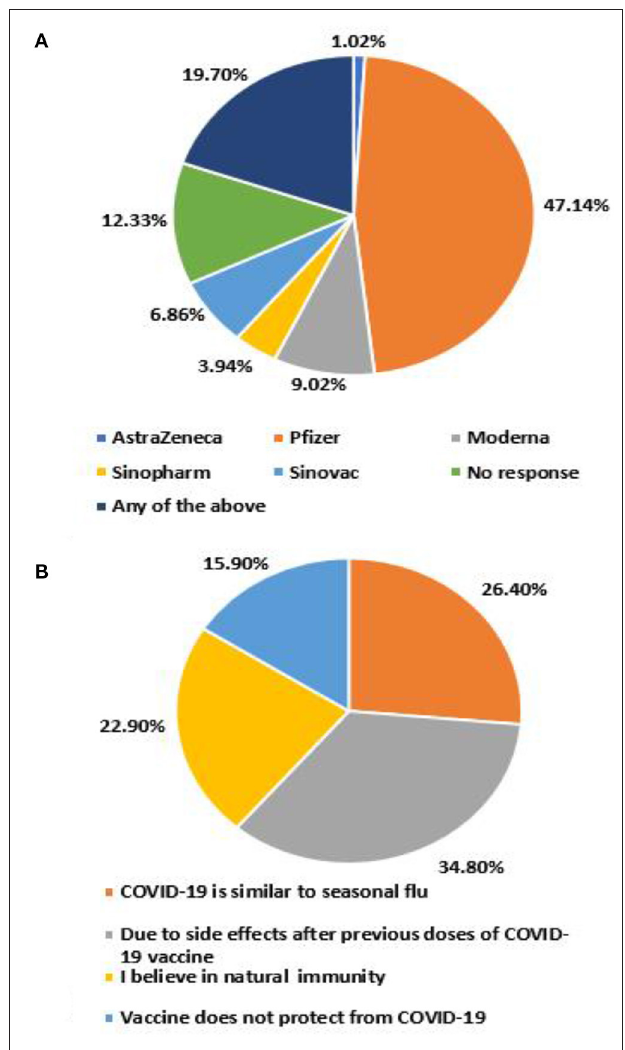
FIGURE 2 | (A) Reasons of unwillingness, (B) choice of booster